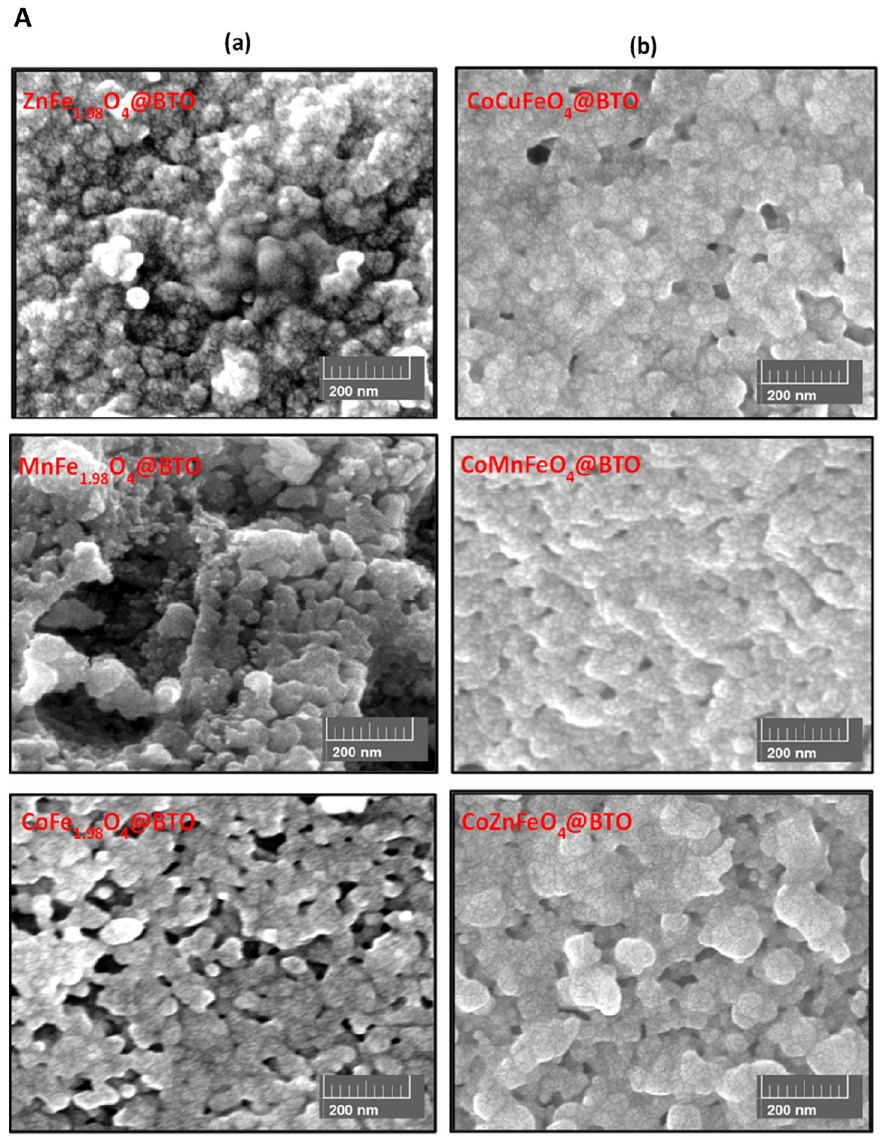
Figure 2. ( A ) SEM images of core–shell ( a ) ZnFe 2 O 4 @BTO, MnFe 2 O 4 @BTO and CoFe 2 O 4 @BTO ( b ) CoCuFe@BTO, CoMnFe@BTO and CoZnFe@BTO MENCs. ( B ) EDX spectra of core–shell ( a ) ZnFe 2 O 4